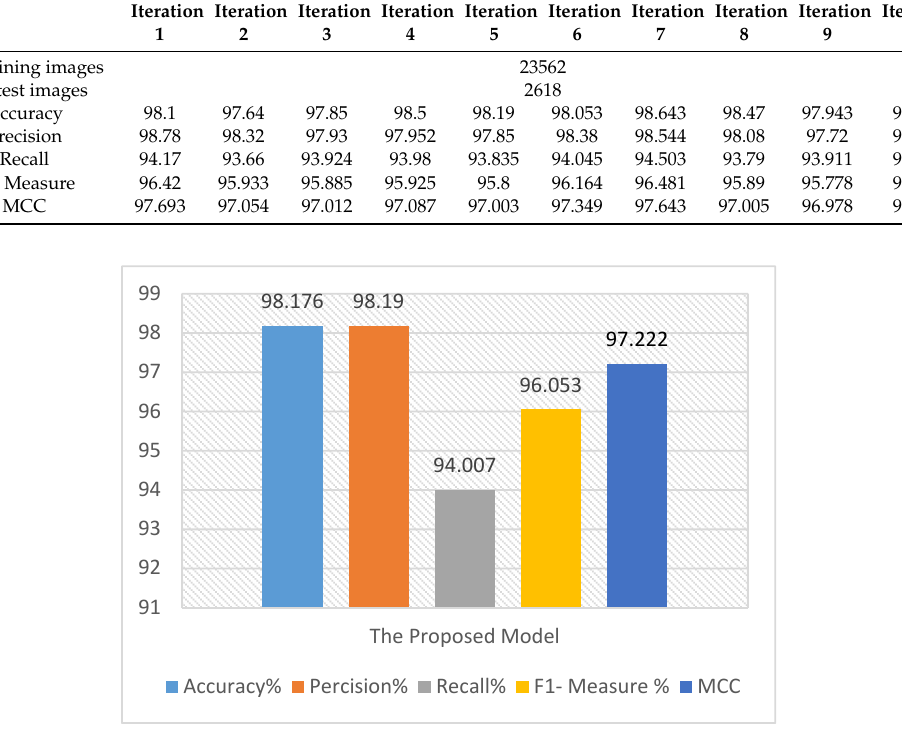
Figure 13. The 10-fold cross-validation average result applied on the overall datasets using our proposed model.